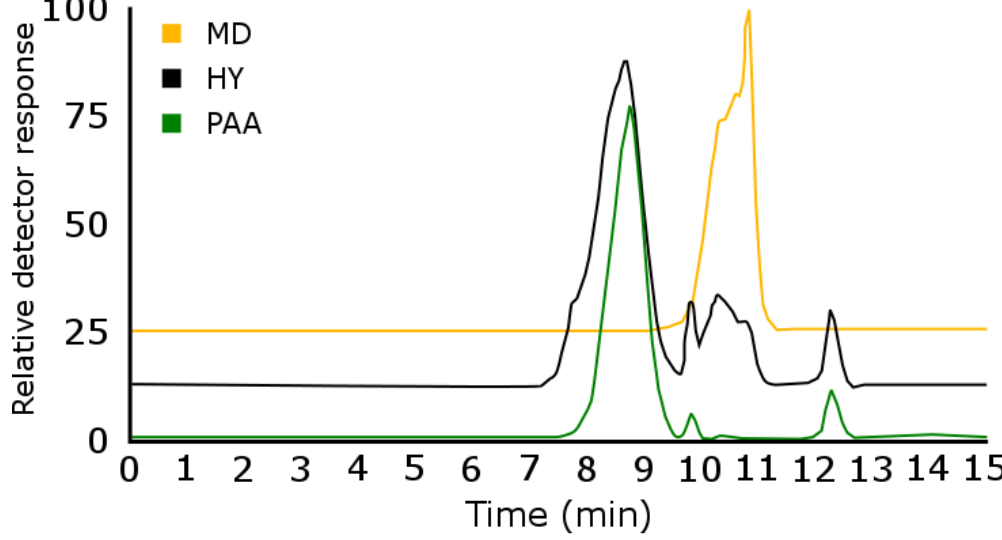
Figure 2. aq-SEC chromatograms of PAA, MD and hybrid polymer (HY) samples. A total of 20 µL of 10 mg/mL injection on a TSK-GEL GMPWxl column (300 × 7.8 mm i.d., 13 µm particles). Chromatograms were recorded at 1.0 mL/min flow rate, with a 0.05-M ammonium acetate buffer (pH 6) using refractive index (RI) detection. Chromatograms are shifted in the y-direction for clarity.